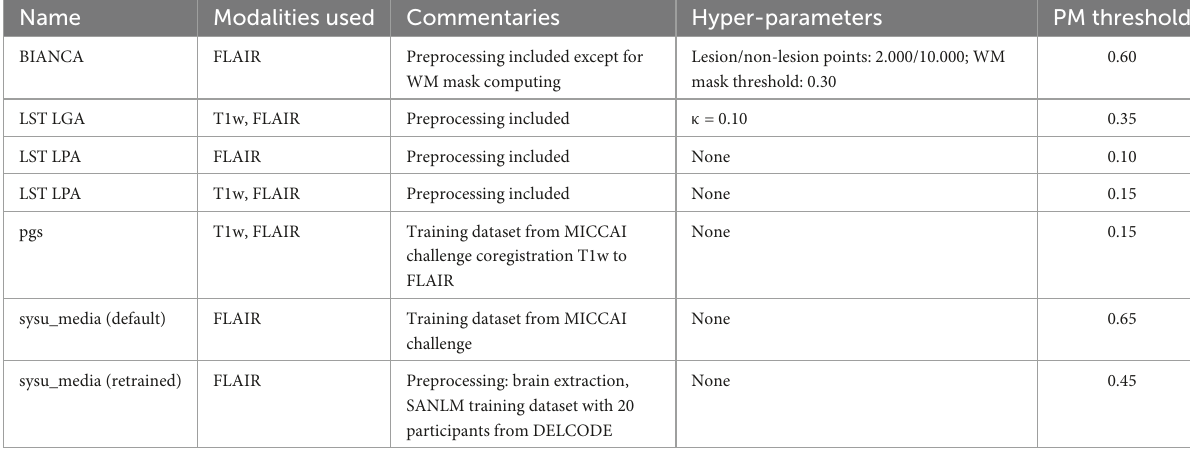
TABLE 2 Description of the tools used and their main